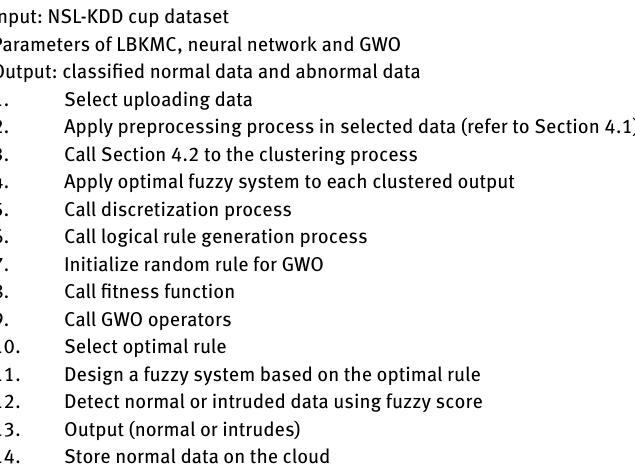
Table 5: Overall